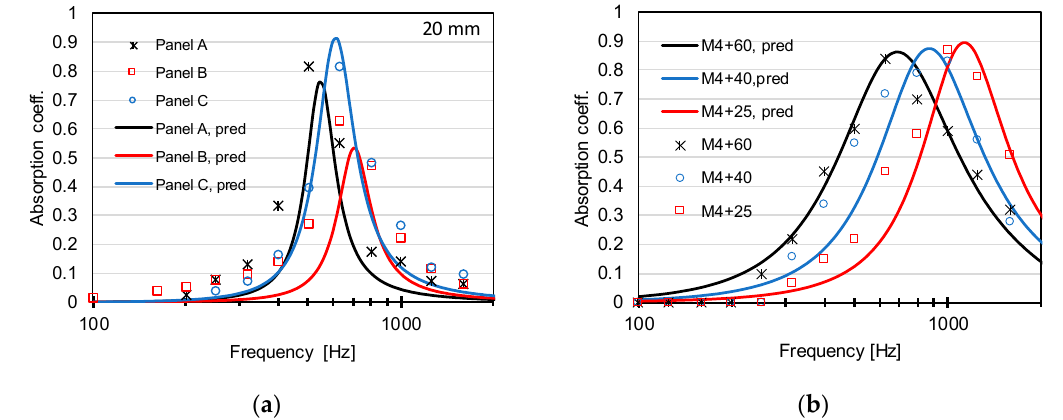
Figure 5. Comparison of the predicted and measured sound absorption coefficients for: ( a ) different perforated panels with a 20 mm cavity; ( b ) micro-perforated membrane M4 with different cavity depth: 25 mm, 40 mm, 60 mm thick.